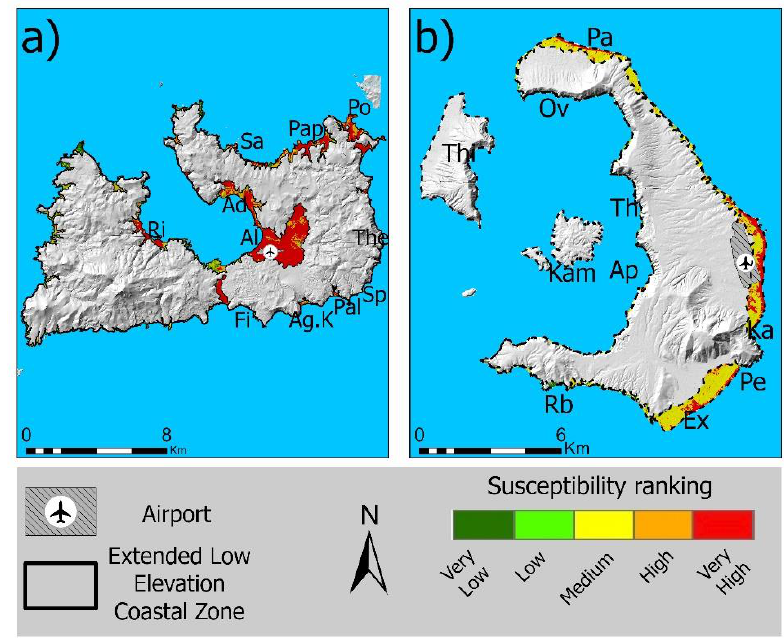
Figure 9. Torrential flood susceptibility maps in Milos ( a ) and Thira ( b ) islands. A large part of the coastal region of Milos Island has a high (24.04%) and very high (50%) susceptibility to the occurrence of torrential floods (Table 7). In the north and west of the island, very low, low, and moderate susceptibility are predominant. In terms of the onshore regions of Thira Island, the eastern and southern regions have high (10.78%) and